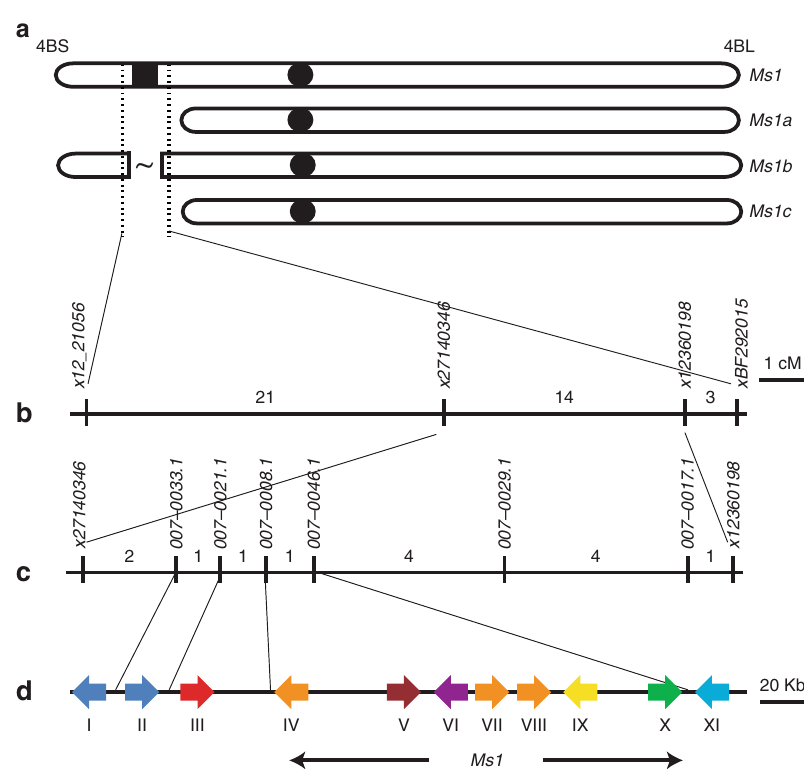
Fig. 1 Map-based cloning of the Male sterility 1 locus on chromosome 4BS. Ms1 was initially mapped to the interval between × 12_21056 and xBF292015 based on genotyping a ( a ) deletion mutant allele series, and then to an ( b ) ~ 0.5 cM interval between × 27140346 and × 12360198 based on 7000 F 2 segregants. c Fine mapping using 14 recombinants deliminated Ms1 to a ( d ) 251-Kb genomic region in wheat. Marker names are in italics. The numbers indicate recombinants identi fi ed for each marker interval. Coloured arrows I to XI denote the position and orientation of predicted wheat genes with a similarity to Brachypodium genes Bradi1g13040 (Cupin domain-containing protein), Bradi1g13040 (Cupin domain-containing protein), Bradi2g05445 (60S ribosomal protein), Bradi1g13030 (Lipid Transfer Protein-Like 94), Bradi4g44760 (F-box/LRR-repeat protein 3), Bradi1g69240 (U-box domain-containing protein), Bradi1g13000 (Lipid Transfer Protein-Like 72), Bradi1g12990 (Lipid Transfer Protein-Like 71), Bradi1g12980 (Putative Para fi bromin), Bradi1g12970 (Putative GNAT family acetyltransferase) and Bradi1g12960 (DUF581 domain-containing protein), respectively. The sequence is available via